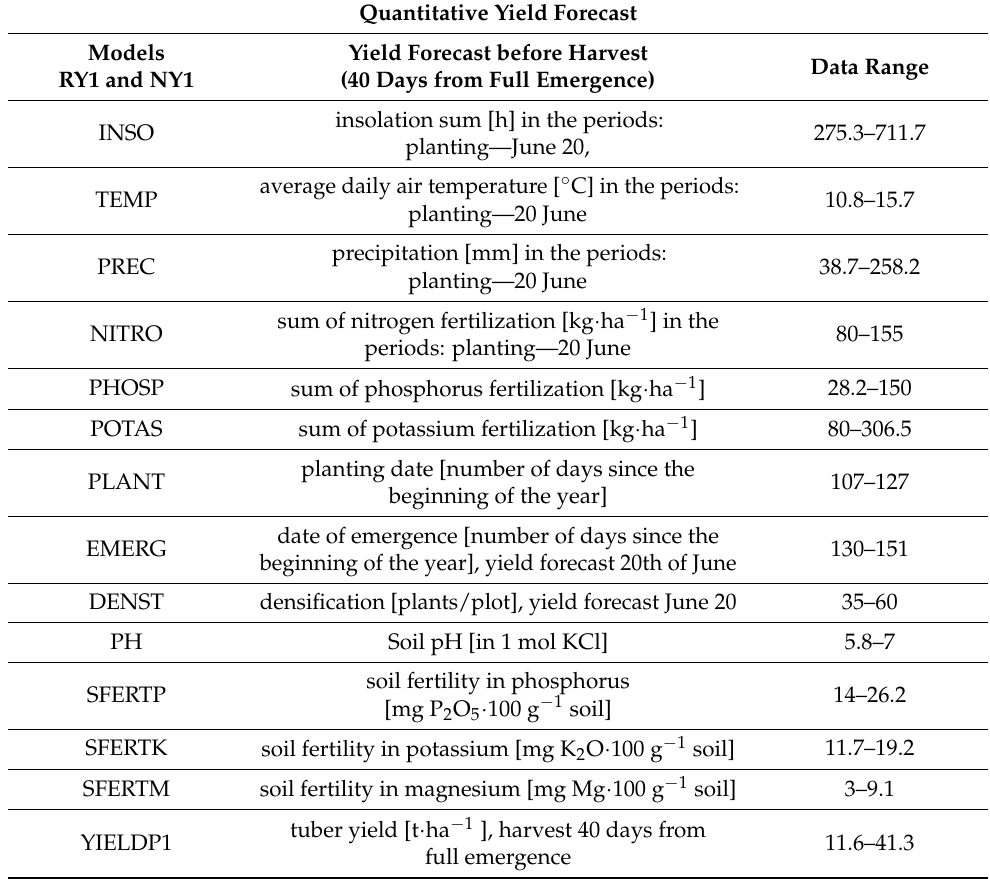
Table 1. Structure and ranges of the most important data in subsets for building and verifying the RY1 and NY1